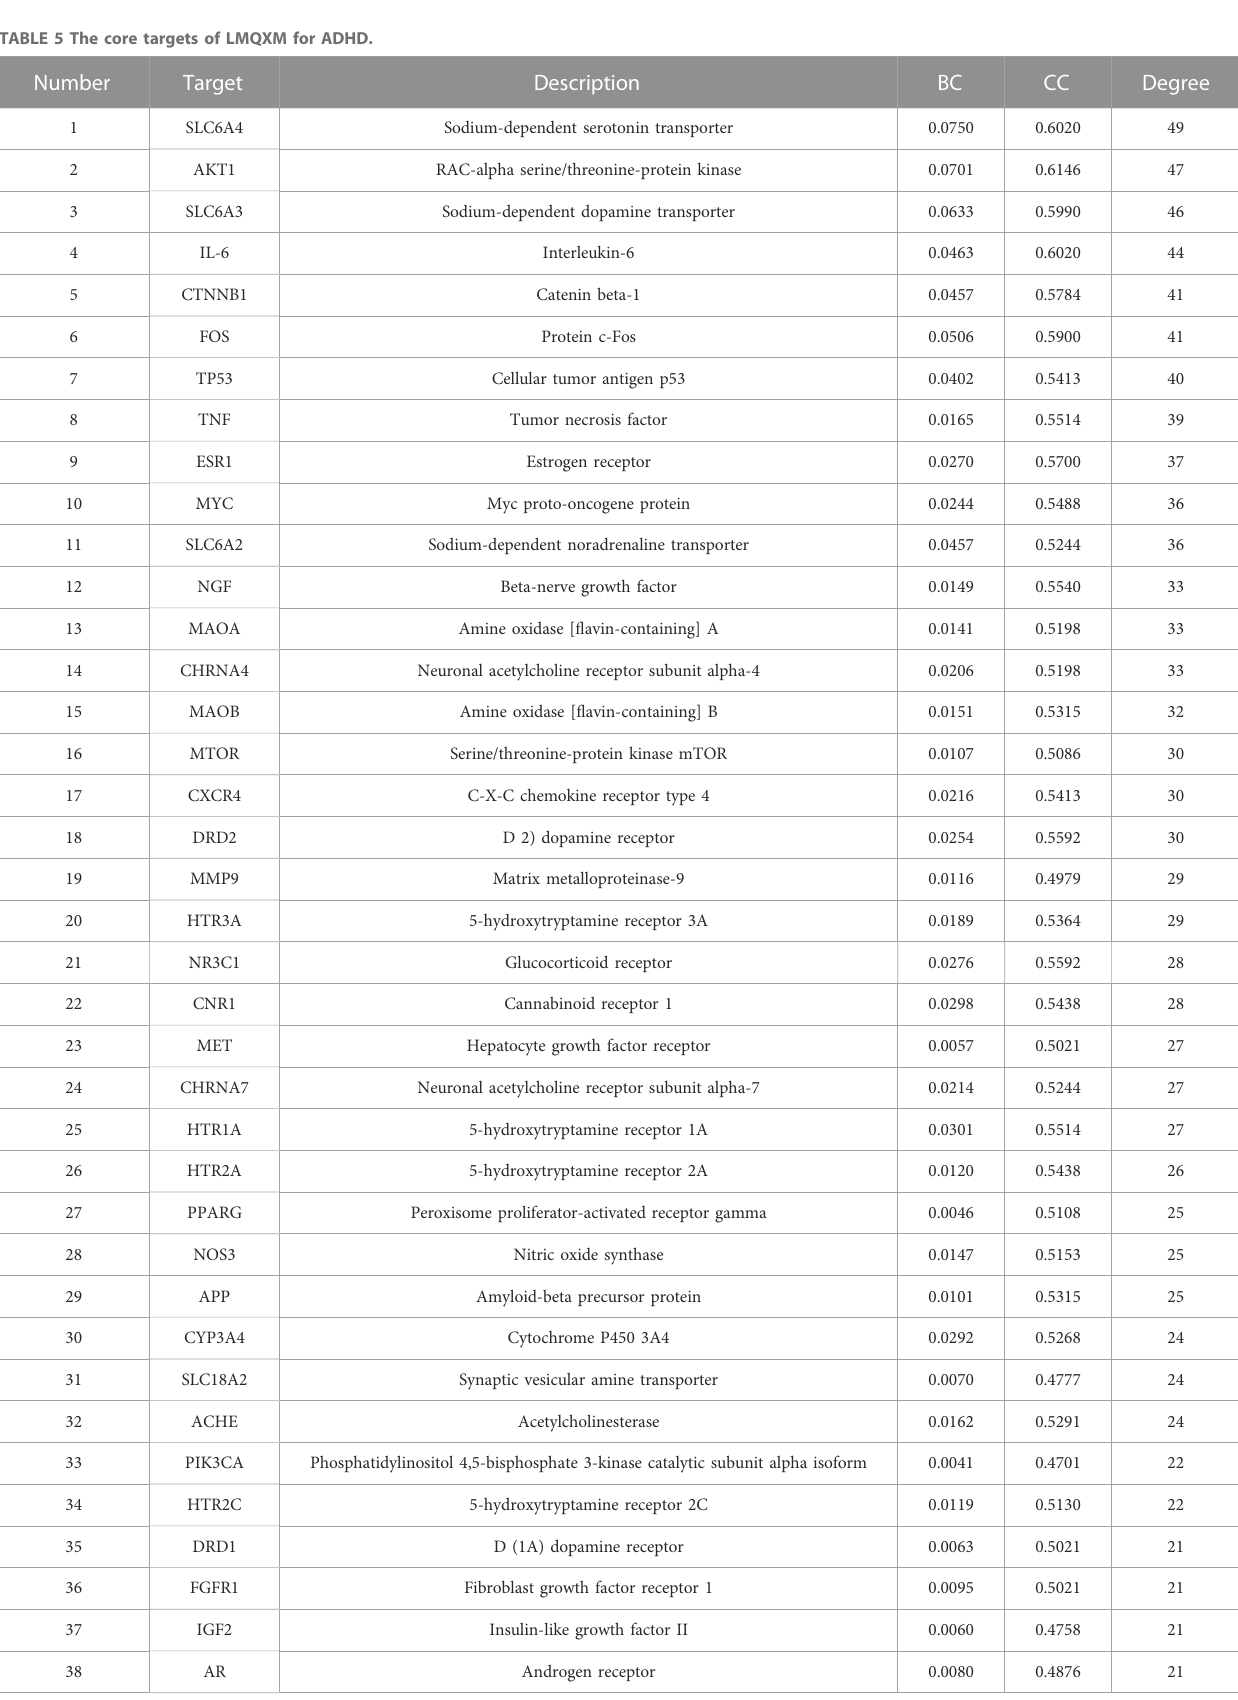
TABLE 5 The core targets of LMQXM for